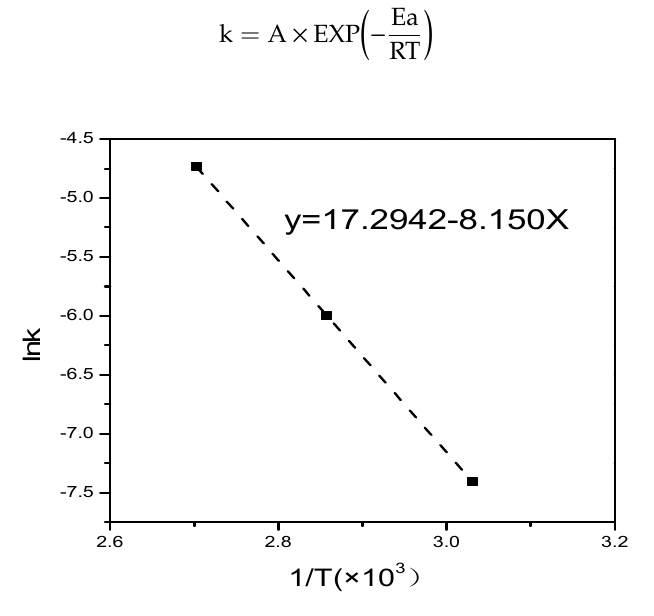
Figure 2. Linear relationship curve between ln k and 1 / T.